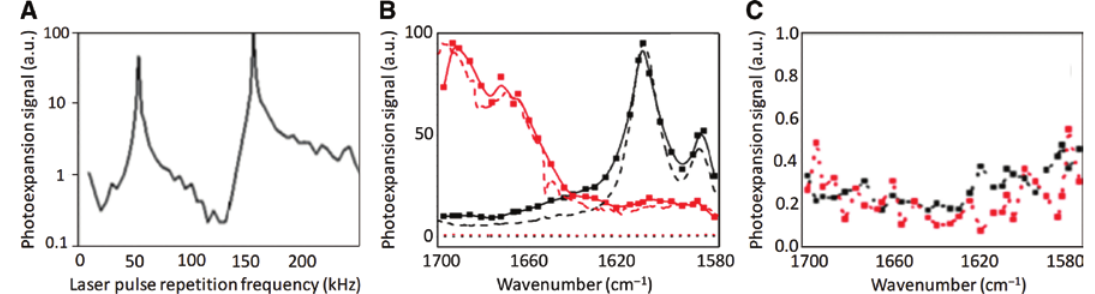
Figure 3: Enhancement of signal by matching the laser repetition rate with the cantilever’s mechanical frequencies [59]. (A) Measured AFM signal using contact mode as a function of various laser pulse repetition rate. (B) AFM-infrared, IR spectrum with laser pulse repetition rate of 155 KHz (on resonance). (C) AFM-IR spectrum with laser pulse repetition rate of 130 KHz (off resonance) (Figures adapted from Ref.